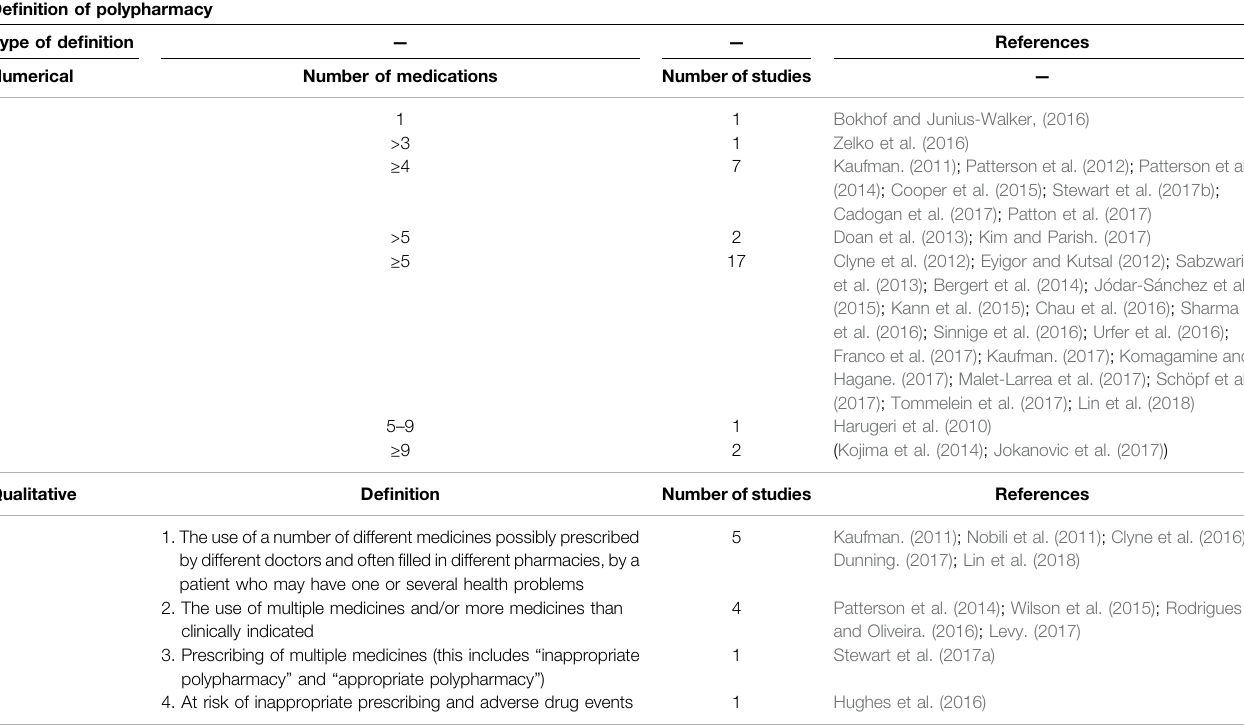
TABLE 1 | De fi nition of polypharmacy used in reviewed